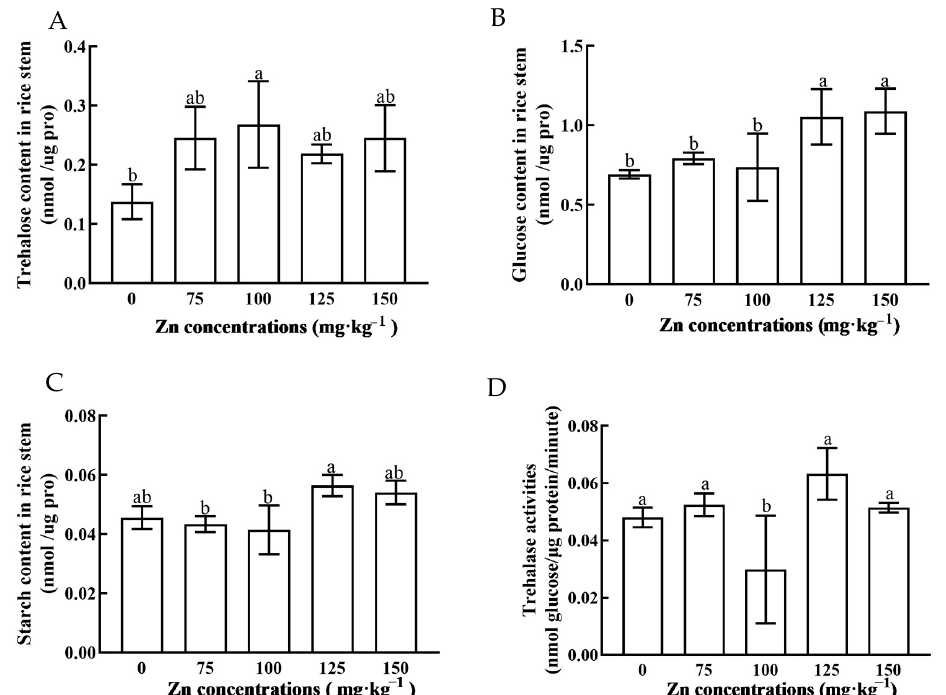
Figure 4. Effects of Zn accumulation on trehalose ( A ), glucose ( B ), and starch ( C ) contents and trehalase activity ( D ) in rice stems. The data are represented as mean ± SE ( n = 3). Tukey’s test was used to detect the significant differences among different groups, and different letters indicate significant